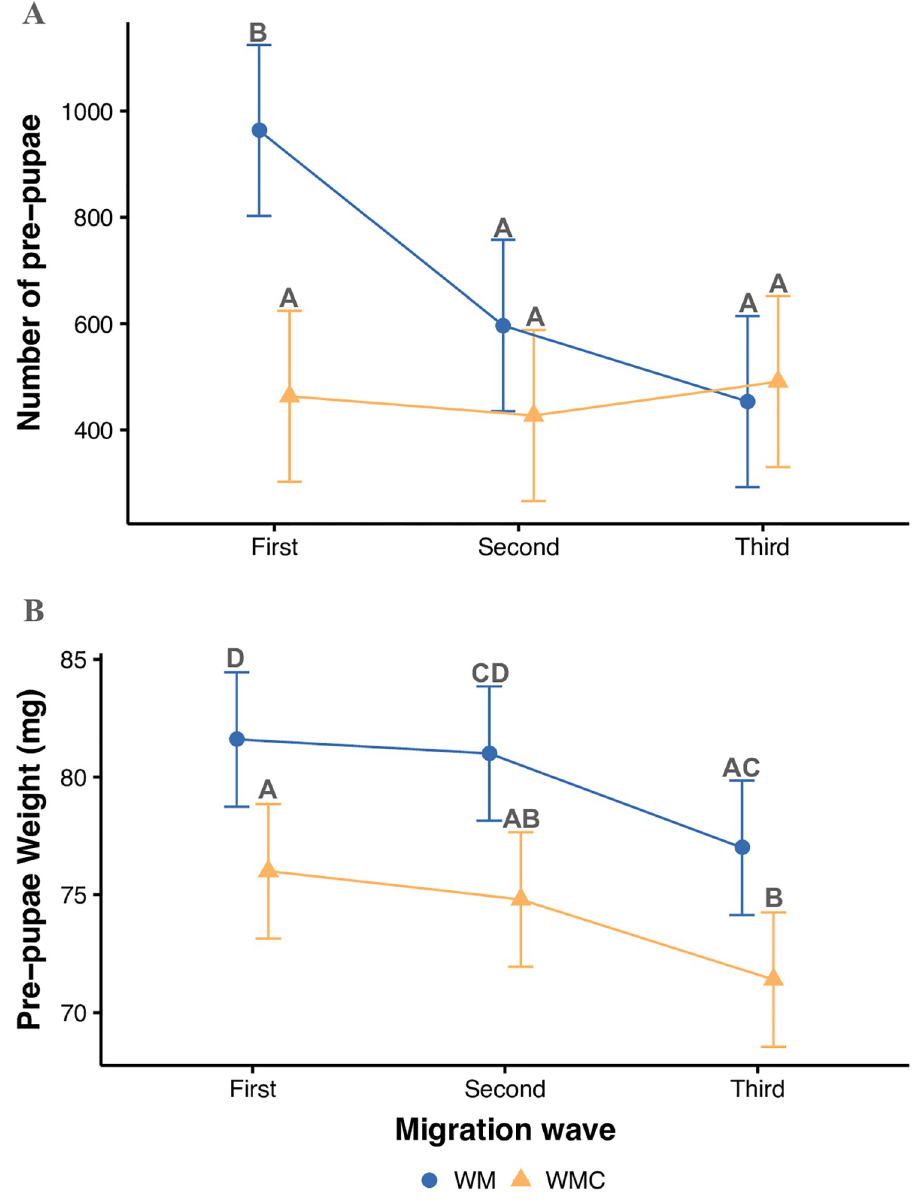
Fig 5. Charcoal delays development and has a negative effect on black soldier fly larvae (BSFL) pre-pupal weight. Charcoal (A) keeps the migration of pre-pupae constant during the duration of the experiment, whereas the waste model (WM) triggers a rapid development evident in the first migration wave that further decreases in the second and third migration waves. The WM-fed pre-pupae weight is (B) higher in all migration waves when compared to pre- pupae fed with the waste model that contains charcoal (WMC). The error bars represent the 95% confidence intervals (CI). Treatments sharing a letter are not significantly different at the 5% level. weight confirmed that charcoal negatively affected the dry weight of BSF pre-pupae (Fig 5B). Pre-pupae weight was significantly higher for insects fed with WM (80 ± 4 mg larva -1 fresh weight) than for those fed with WMC (74 ± 3 mg larva -1 fresh weight) (X 2 = 25.37, p < 0.0001). A weight reduction tendency was observed in the third migration wave, probably caused by